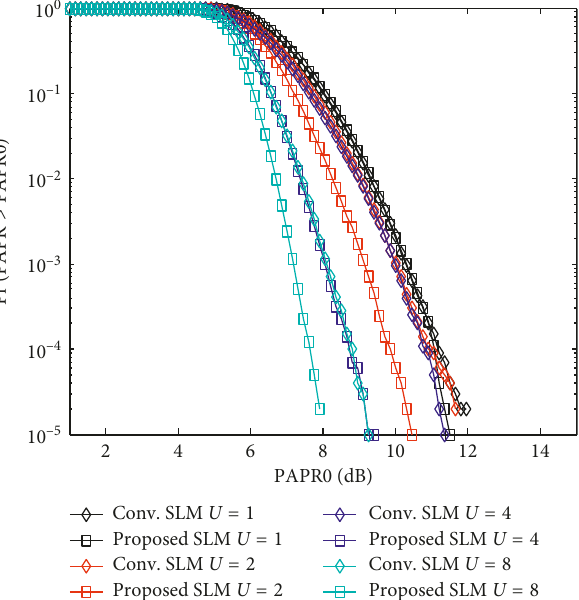
Figure 5: Comparison of SLM given in [5] with proposed SLM for U � 1, 2, 4, and 8, N � 64, and 4-PSK.